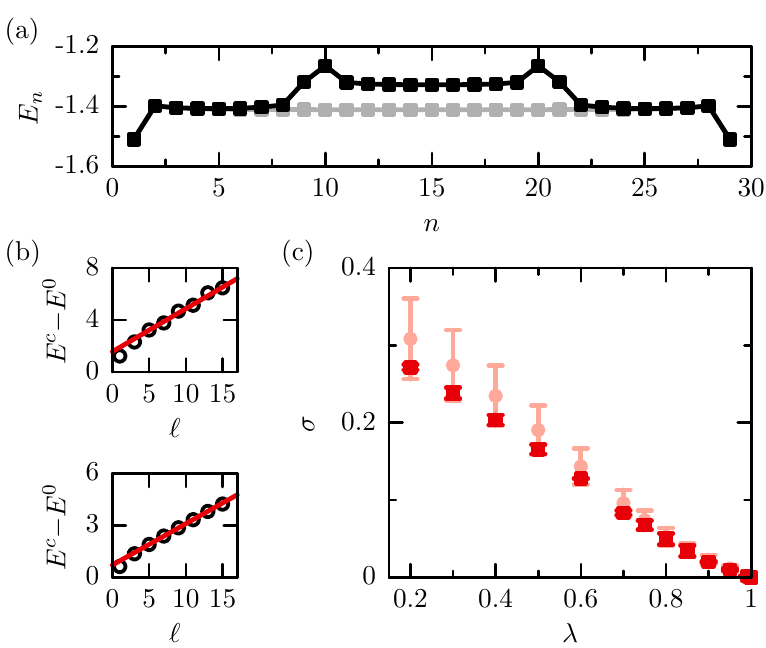
Figure 8: String tension from potential energy between two static charges ± 1. (a) Cut through the energy landscape at λ = 0.7, size 30 × 10 from plaquette energies = (cid:80) E E with charges at n − = 10, n + = 21 ( (cid:96) = 11) (black) and without n m , n m charges (grey). (b) Excess energy over intercharge distance (cid:96) , fitted linearly (red) for λ = − 0.3 (top) and λ = 0.3 (bottom) in the 24 × 8 lattice. (c) Fit-slopes σ in the RVBS phase, for sizes 24 × 8 (red) and 30 × 10